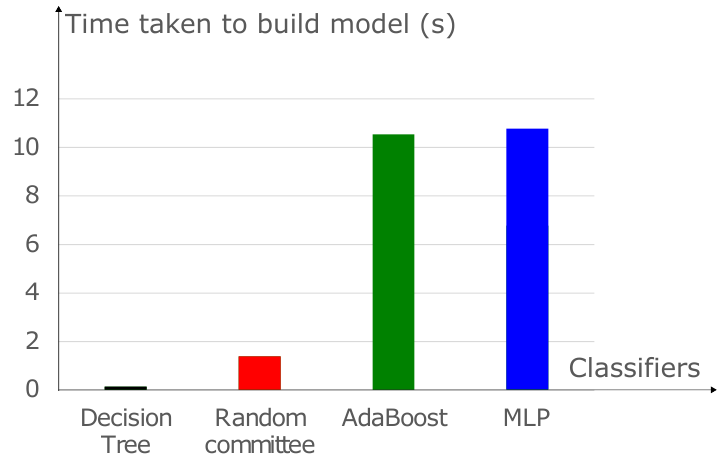
Figure 5. Time taken to build model: random committee Vs. AdaBoost Vs. J48 Vs. MLP with L = 3, N A = 4, SNR SR = 20dB, SNR = − 5dB, e 2 = 0.1 and | ρ | =